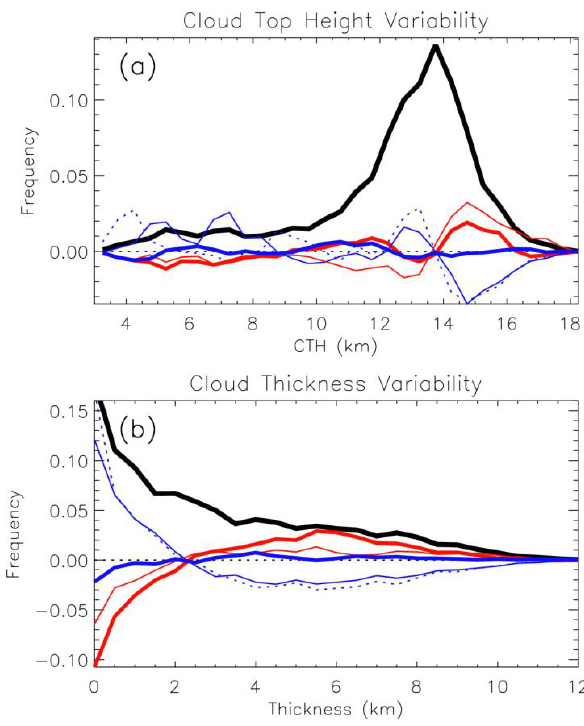
Figure 4: Probability Distribution Function (PDF) of cloud top height (a) and geometrical cloud thickness (b) with all regimes included (thick black line), and PDF difference (regime-total) for the following large-scale atmospheric regimes: Moist Easterly (thick blue line), Easterly (thin solid blue line), Dry Easterly (thin dotted blue line), Active monsoon (thick red line), and Shallow Westerly (thin red line).